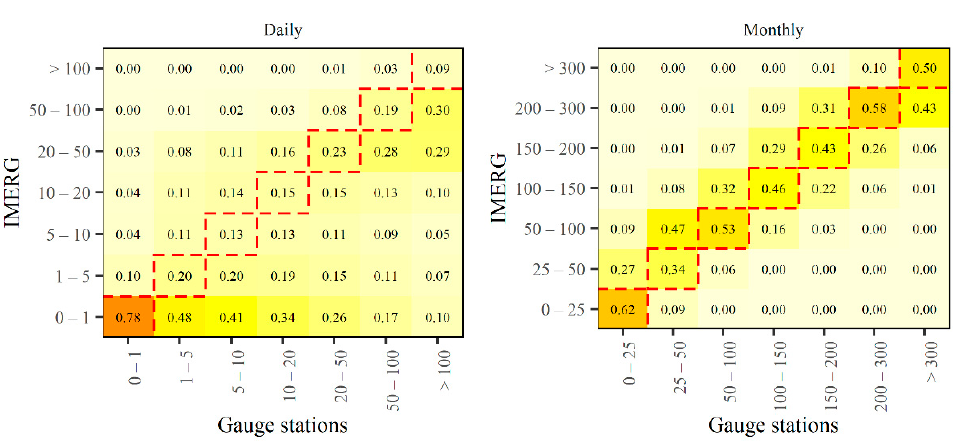
Table 2. Summary of error metrics on a daily and monthly scale of the satellite precipitation prod- ucts in Paraná regions. The metrics were calculated based on mean areal precipitation.